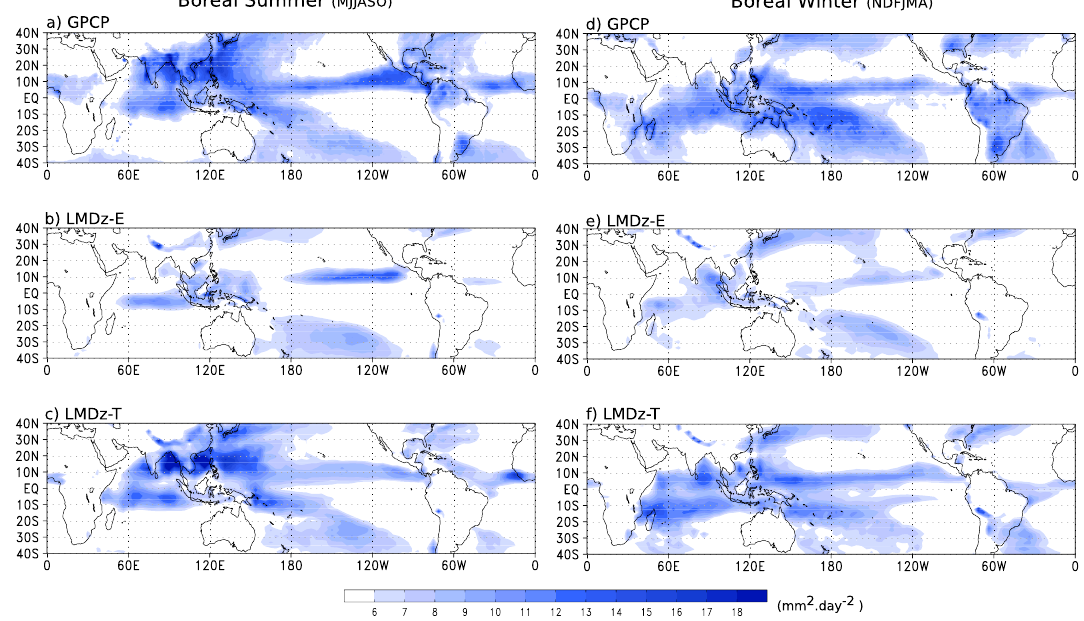
Fig. 1. Standard deviations of precipitation (mmday − 1 ) in boreal summer (May to October: MJJASO, left panels) and boreal winter (Novem- ber to April: NDJFMA, right panels): (a, d) GPCP (1997–2008), (b, e) LMDz-E (20yr) and (c, f) LMDz-T (20yr). The white (blue) colours show relatively low (high) values of